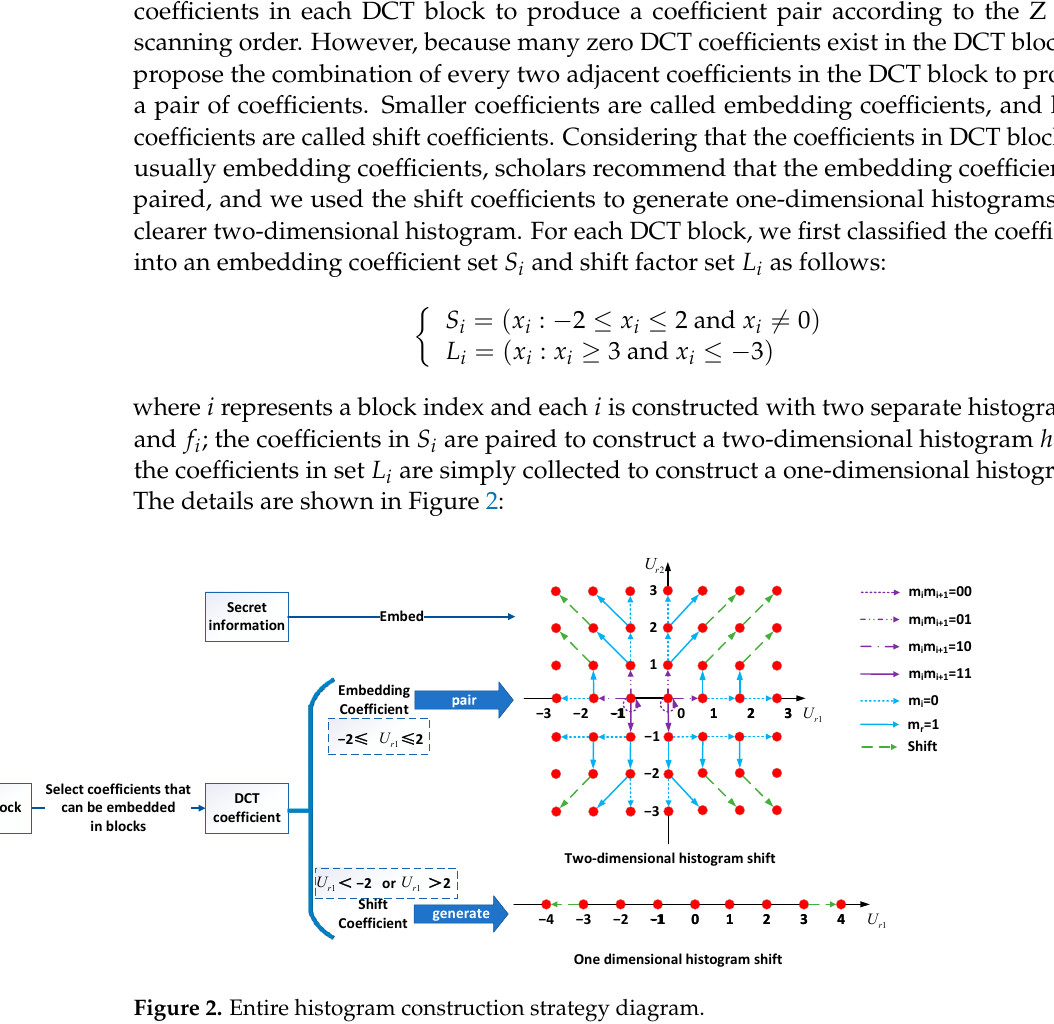
Figure 2. Entire histogram construction strategy diagram.